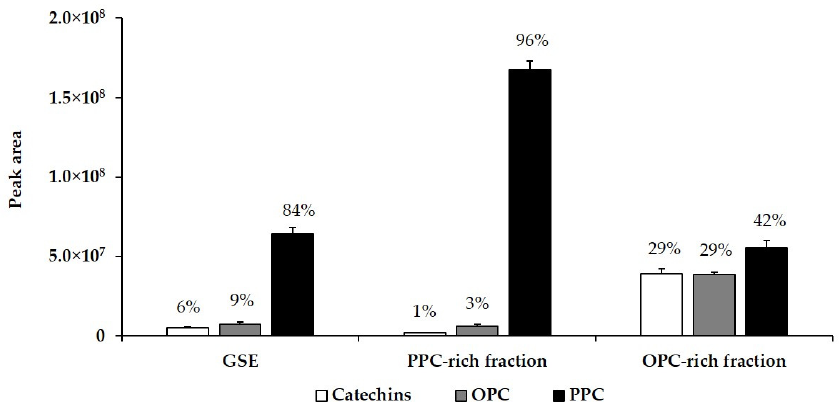
Figure 4. Sum of peak areas from chromatograms (Figure 3), corresponding to the sum of all catechins, total oligomeric procyanidin (OPC) and polymeric procyanidin (PPC) of the grape seed extract (GSE) and its fractions.